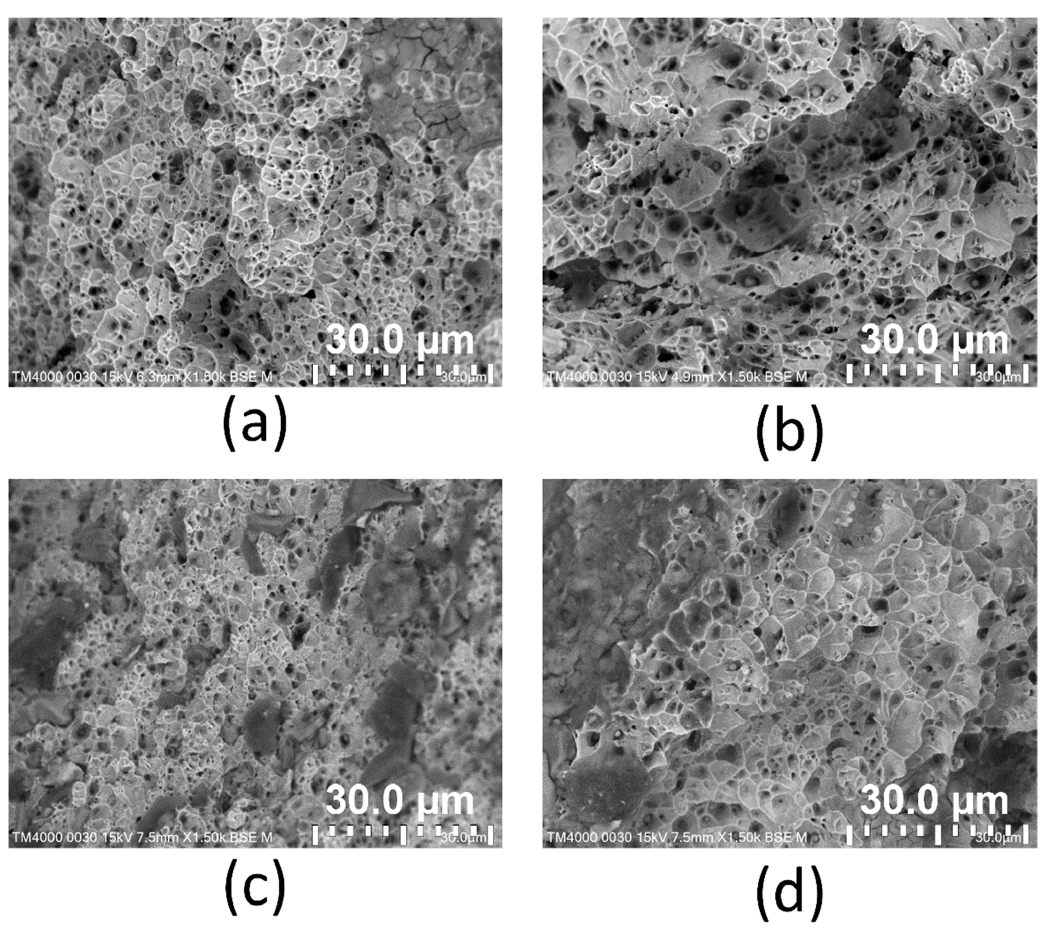
Figure 8. SEM fracture surface of samples at different WAAM strategies: ( a ) strategy 1, ( b ) strategy 2, ( c ) strategy 3, and ( d ) strategy 4.